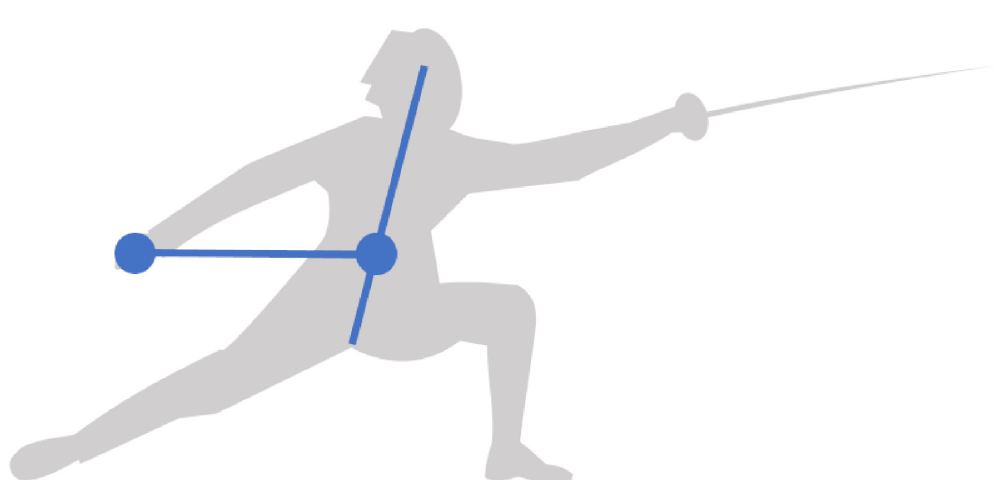
Fig 23. Free hand space. It is defined by a line segment between the free hand and the body center. The free hand movement is evaluated relative to the body center.